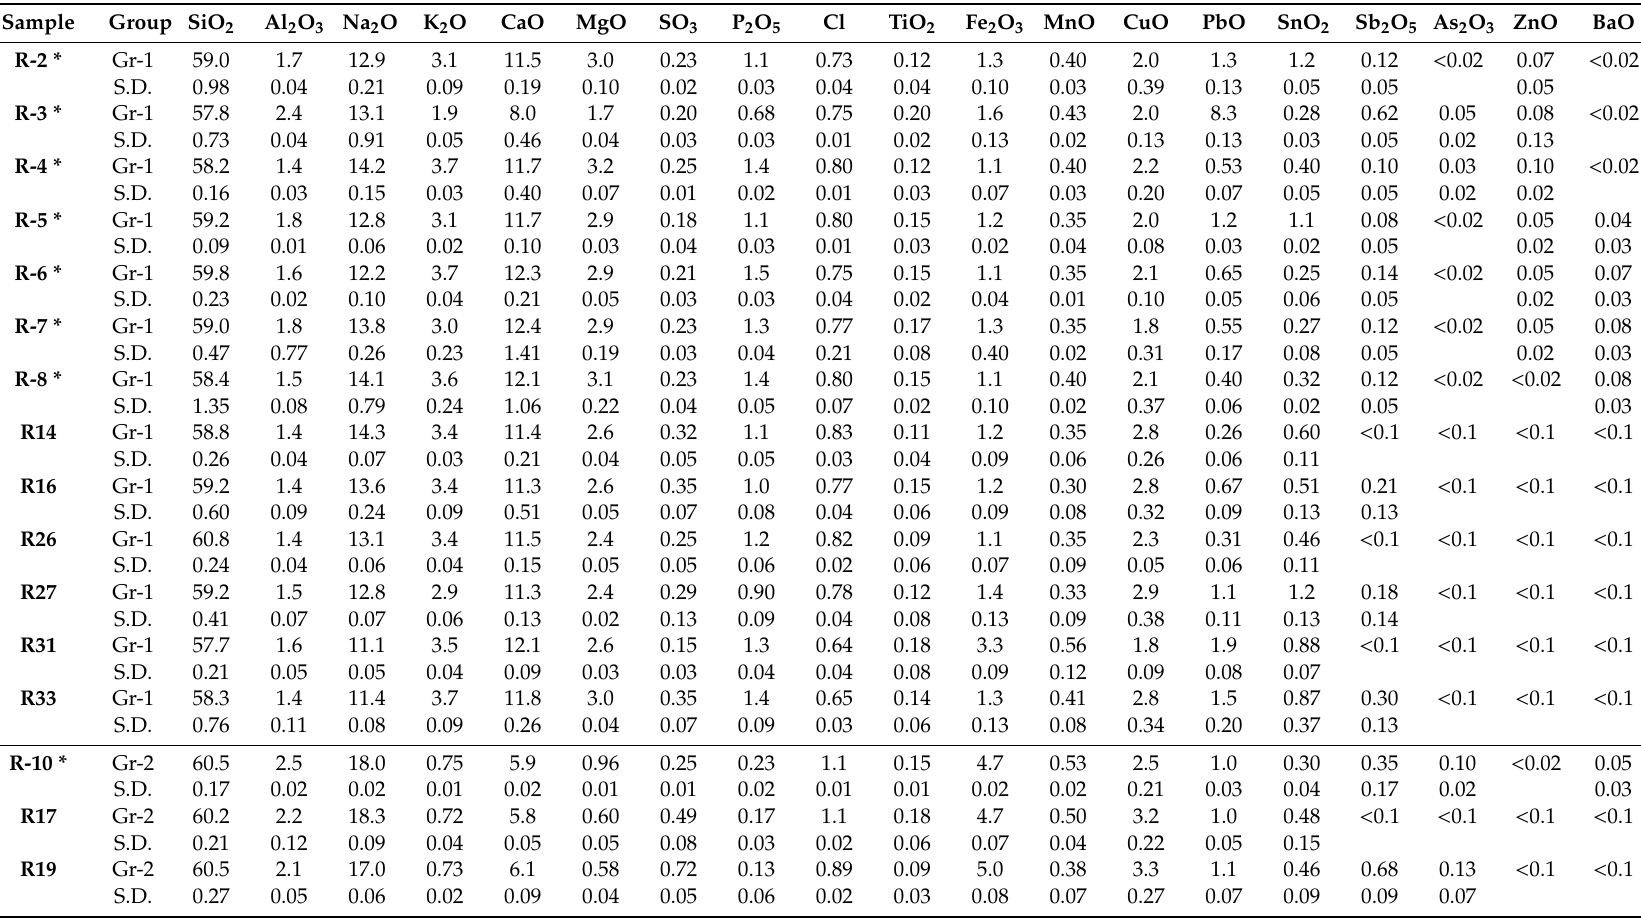
Table 3. Average quantitative chemical composition (wt.% oxides) of the representative samples for each red hue (Gr-1, Gr-2, Gr-3, Gr-4, Gr5). With major and minor oxide in wt.% oxide. * Samples analysed using EPMA, while the other samples were analysed by SEM–EDS. S.D.—Standard Deviation; five measurements were performed (at least) for each